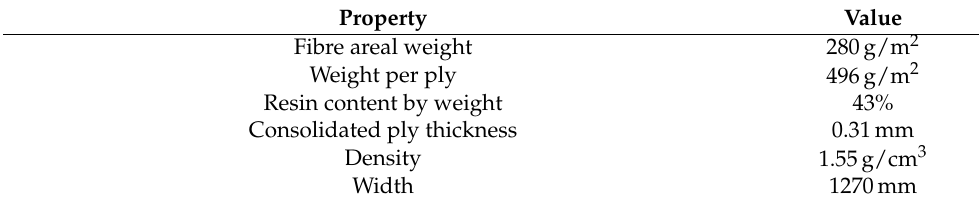
Table 2. Basic physical properties of individual pre-impregnated ply.